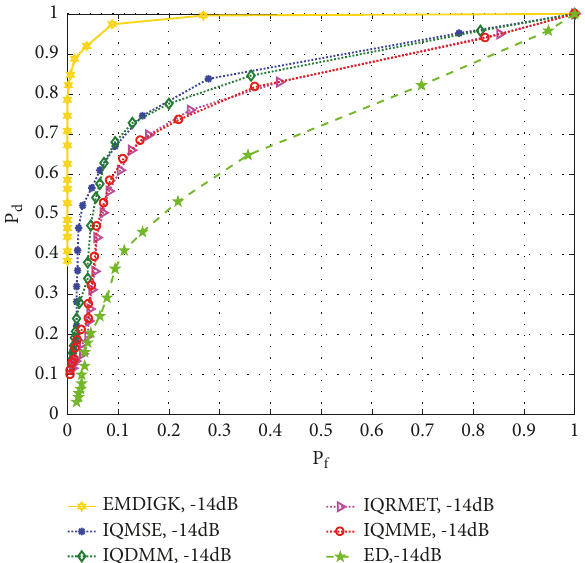
Figure 6: The ROC curve with GFV under 𝑆𝑁𝑅 = −14 dB.